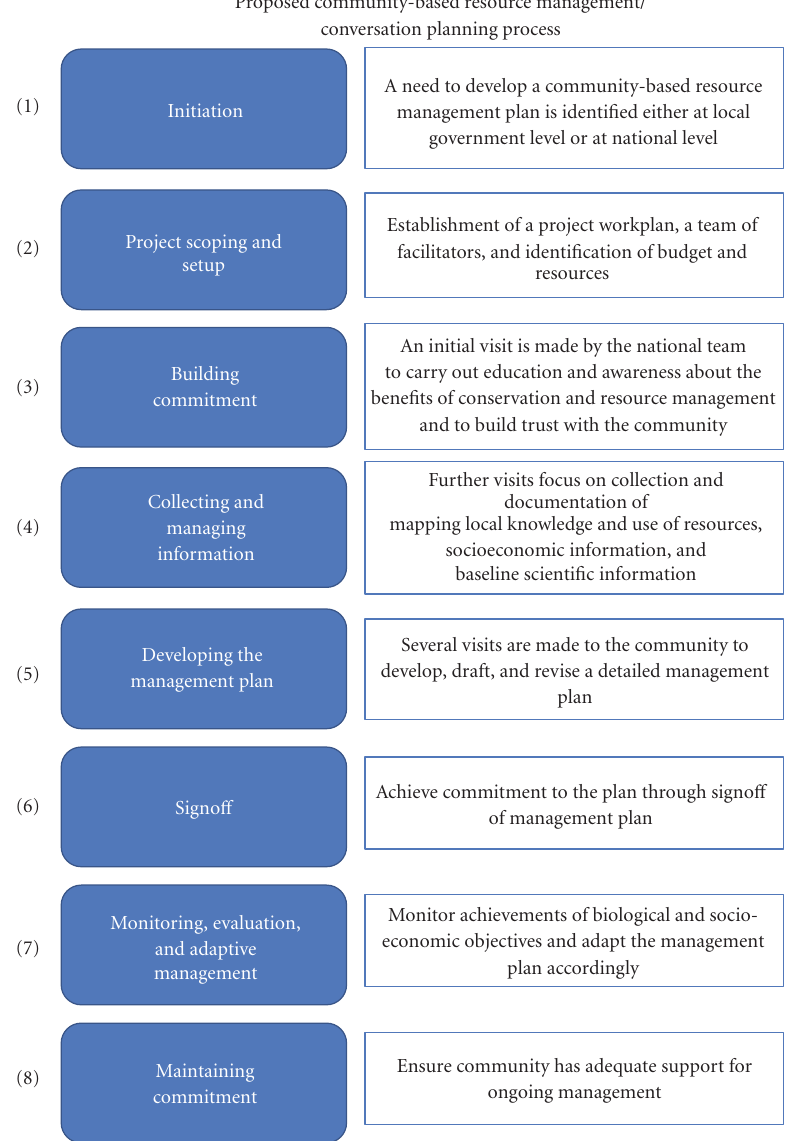
Figure 3: Summary diagram of the process for community-based conservation and resource management planning.